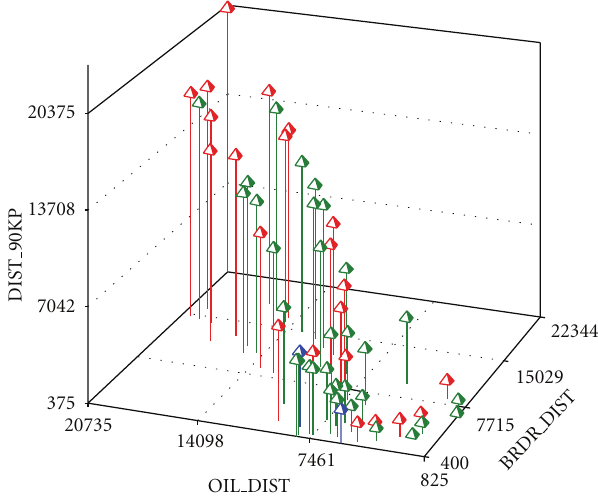
Figure 1: Example of El Paso school sites chosen (red) to be representative of all other school sites (green) for the variables of distance to petroleum facility point source (OIL DIST, m), distance to nearest road segment ≥ 90,000 cars/day (DIST 90KP, m), and distance to nearest border crossing (BRDR DIST). (Blue sites are compliance